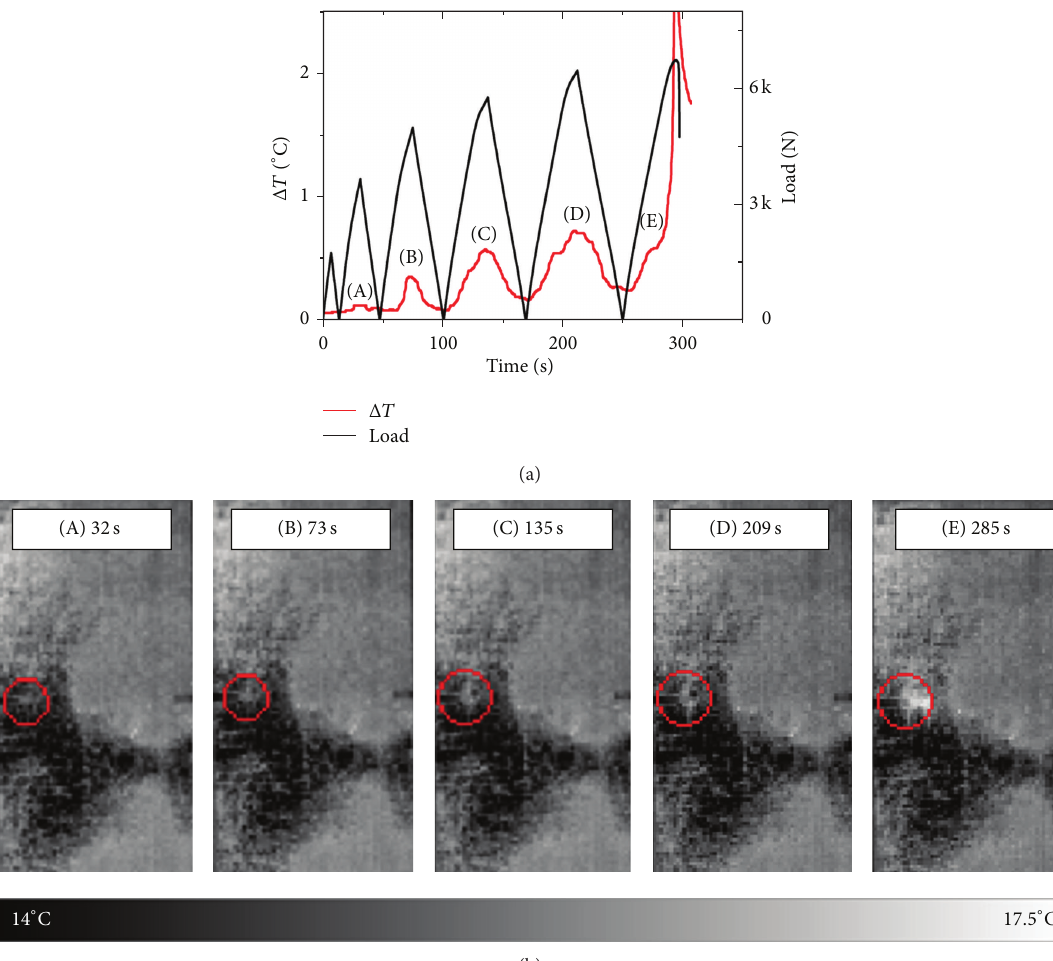
Figure 4: (a) Δ𝑇 and load versus time for a 0.35 notch-to-width ratio specimen loaded in cyclic tension. Sequential alphabet letters indicate instance of thermographs presented in